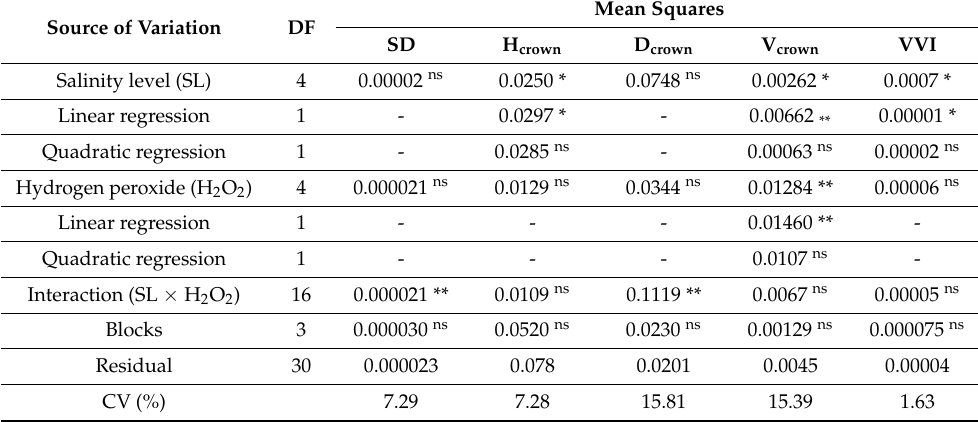
Table 3. Analysis of variance (F-test) summary of stem diameter (SD), crown height (H crown ), crown diameter (D crown ), crown volume (V crown ), and vegetative vigor index (VVI) of soursop plants cv. Morada Nova irrigated with saline water and subjected to foliar application of hydrogen peroxide at 210 days after transplantation. Mean Squares Source of Variation DF SD H crown D